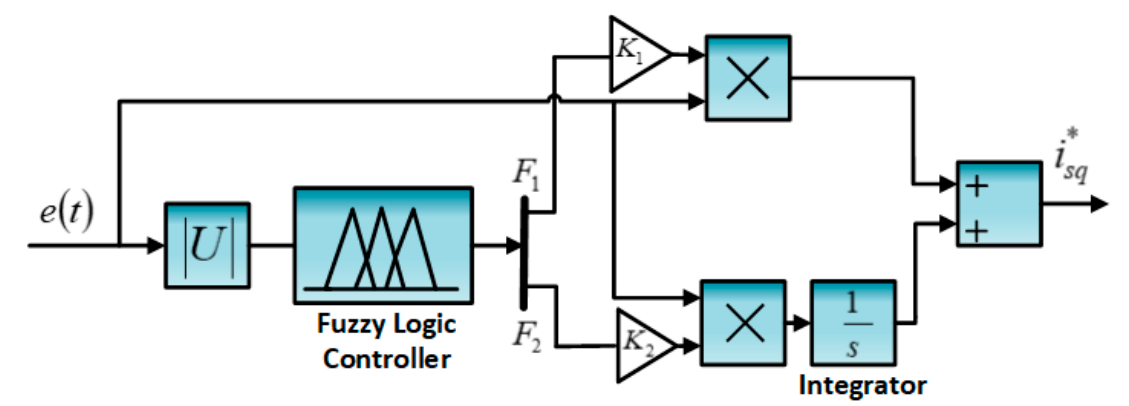
Figure 6. Adaptive PI controller.